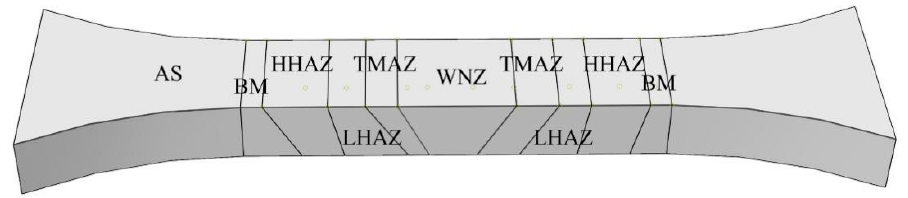
Figure 10. Partitioned performance joint model of the FSW joint.